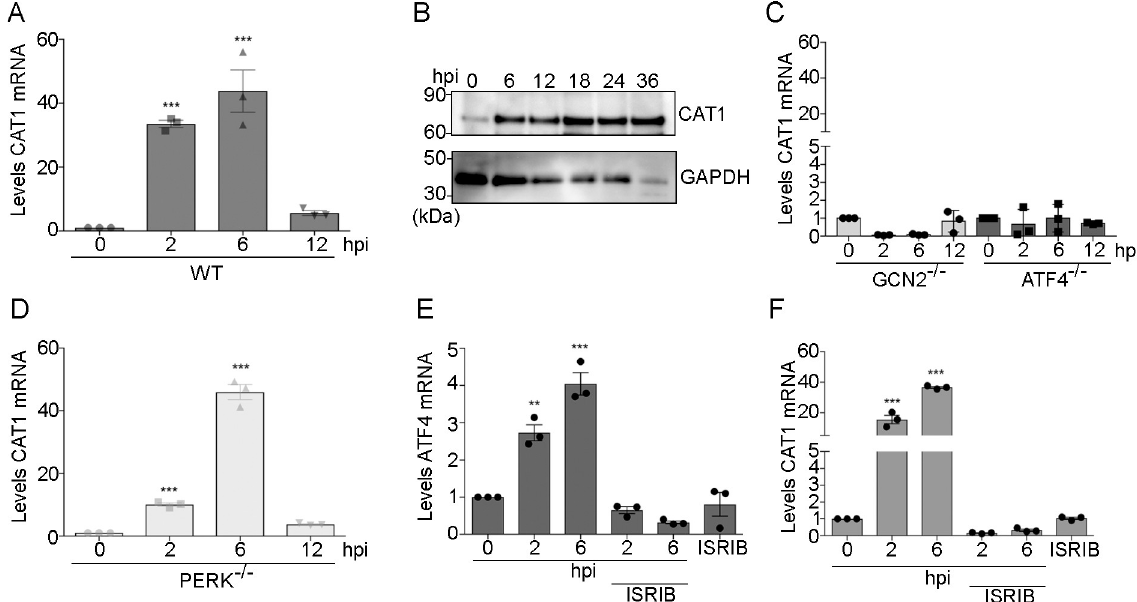
Fig 4. Host GCN2/ATF4 pathway induces CAT1 expression upon Toxoplasma infection. (A) Levels of CAT1 mRNA were measured by RT- pPCR in wild-type (WT) MEF cells infected with Toxoplasma for up to 12 h. Values of infected cells were normalized to mock-infection. Error bars represent standard deviation (n = 3) ��� p < 0.0005, ���� p < 0.0001. (B) Levels of CAT1 protein were measured by immunoblot in WT MEF cells infected with Toxoplasma for up to 36 h. As a normalization control, GAPDH protein levels were measured in the same lysate preparation. N = 3; numbers below the immunoblot indicate the densitometry values for CAT1/GAPDH. (C) GCN2 -/- and ATF4 -/- or (D) PERK -/- MEF cells were infected with Toxoplasma for the indicated time. Levels of CAT mRNA were measured by RT-qPCR, and the values of infected cells were normalized to mock-infected cells. Error bars show standard deviation (n = 3) ��� p < 0.0005, ���� p < 0.0001. (E-F) WT MEF cells were infected for the indicated times in presence or absence of the ISR inhibitor ISRIB. Levels of ATF4 and CAT1 mRNAs were measured by RT-qPCR. Values of infected cells were normalized to mock-infected cells ( ± SD, n = 3) ��� p < 0.0005.